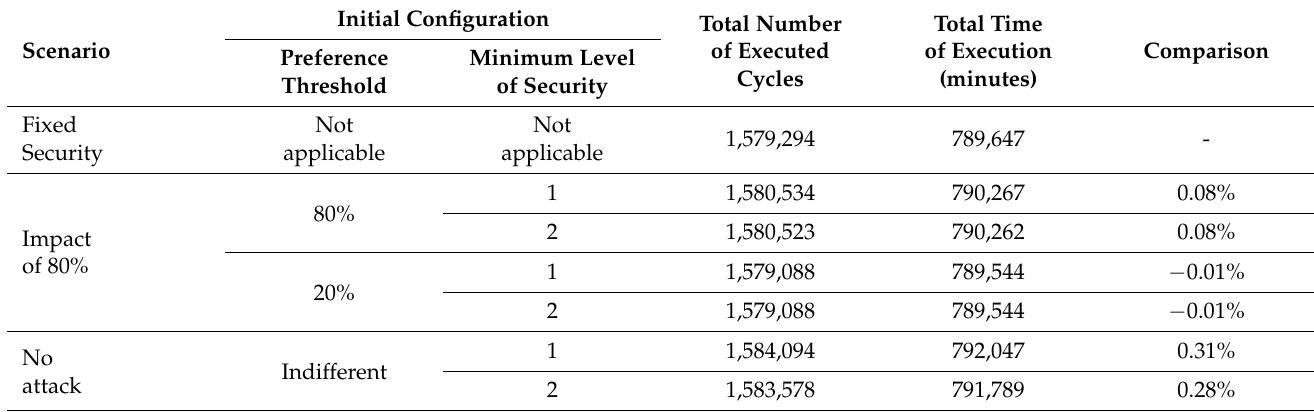
Table 9. Lifetime of a sensor taking into account the energy cost of security and message